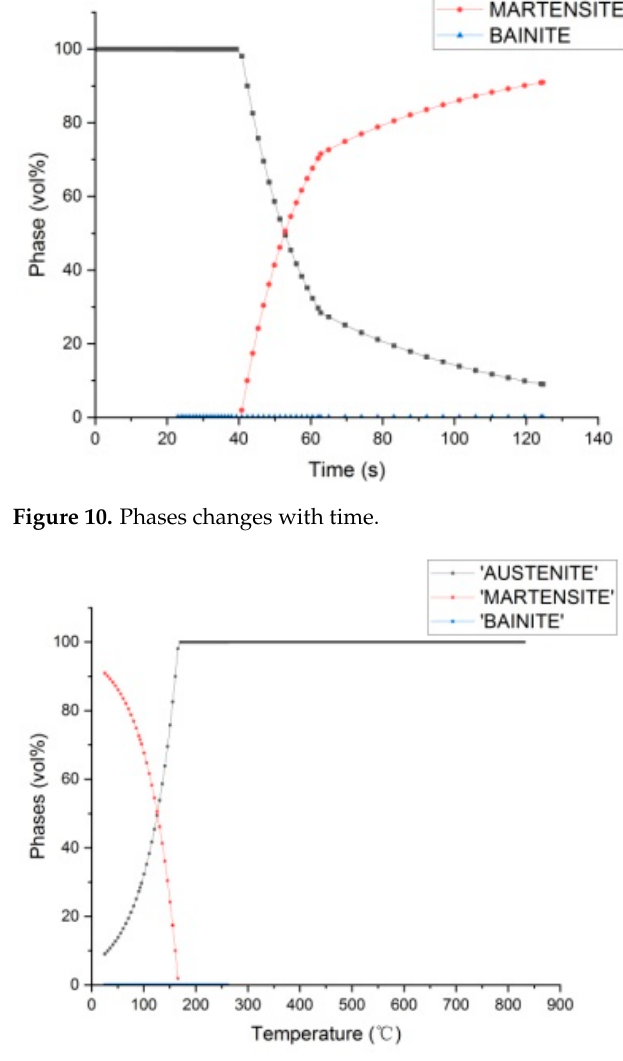
Figure 11. Phases changes with temperature.